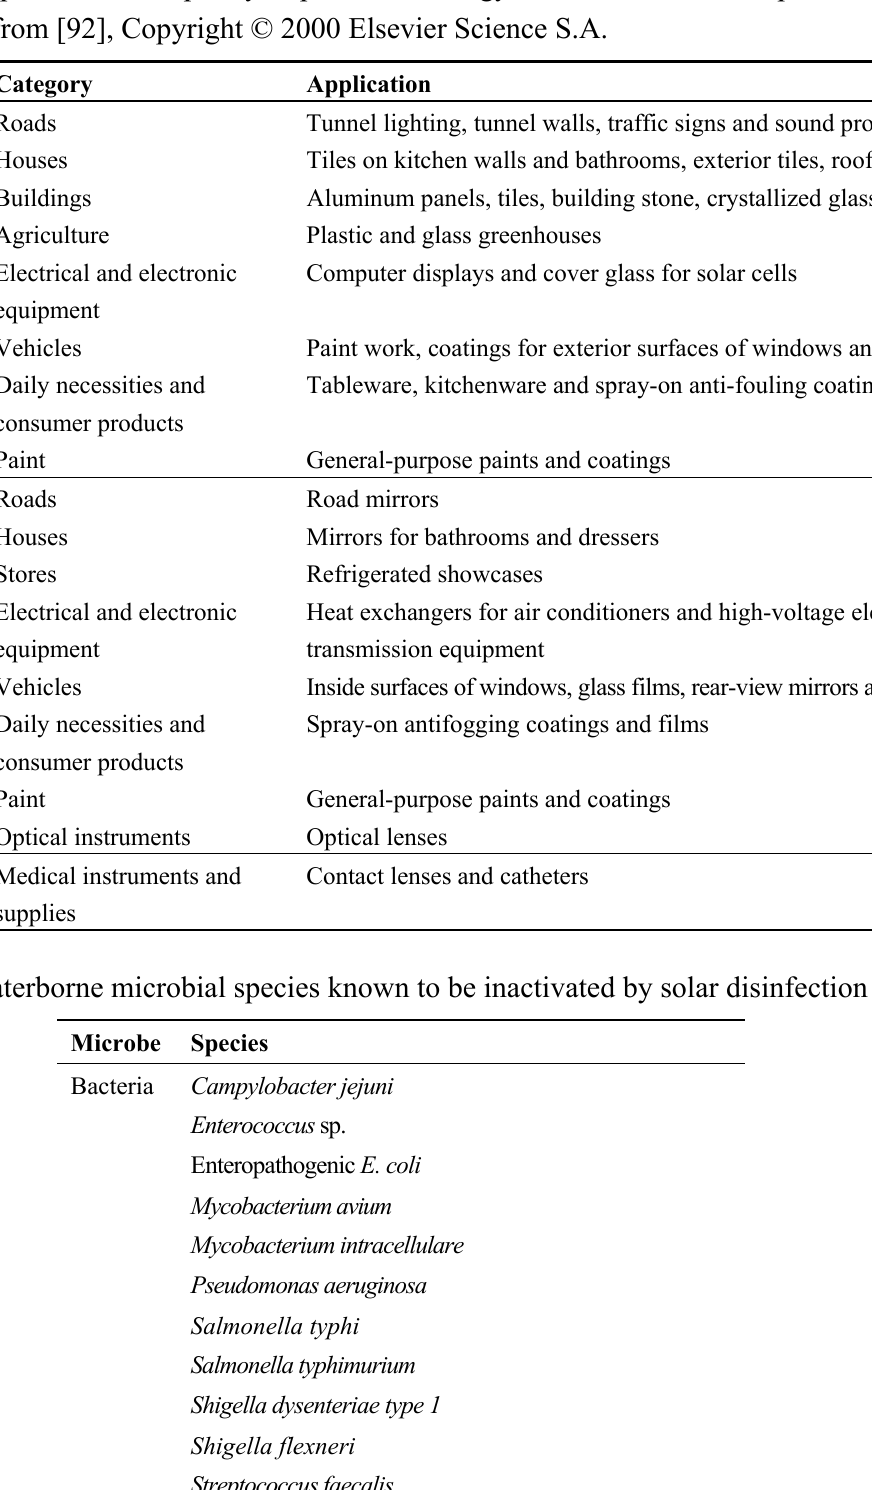
Table 2. Applications of super hydrophilic technology. Note: this Table is reproduced with permission from [92], Copyright © 2000 Elsevier Science S.A.